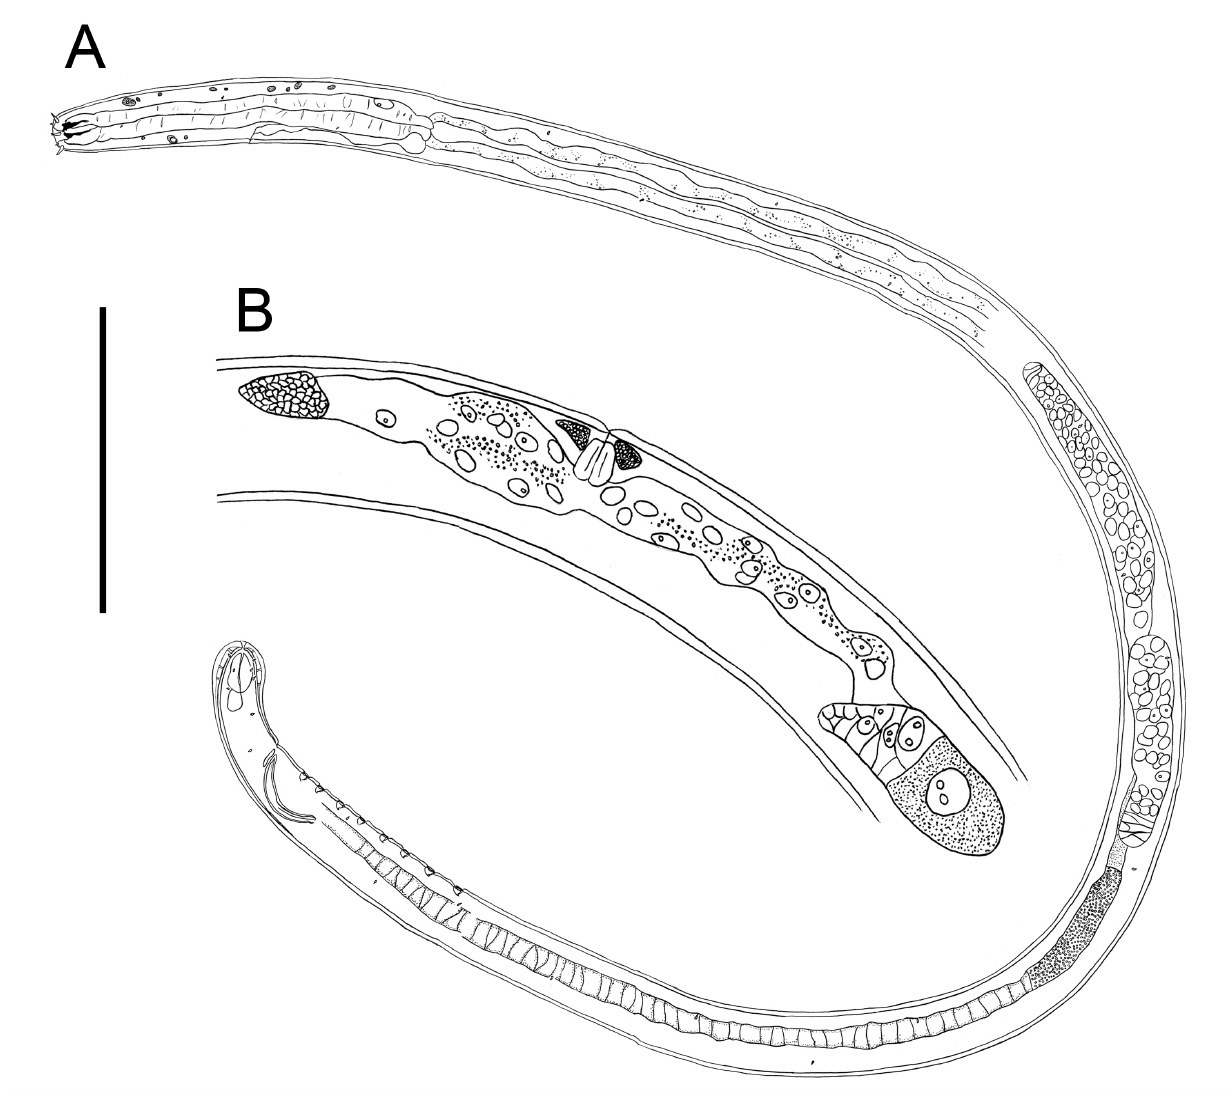
Fig. 2. Synonchiella rotundicauda sp. nov. A . Entire male. B . Female reproductive system. Scale bar: A = 150 µ m; B = 75